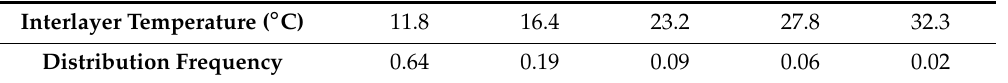
Table 14. Representative temperature distribution frequency between decks in Ulanchabu.